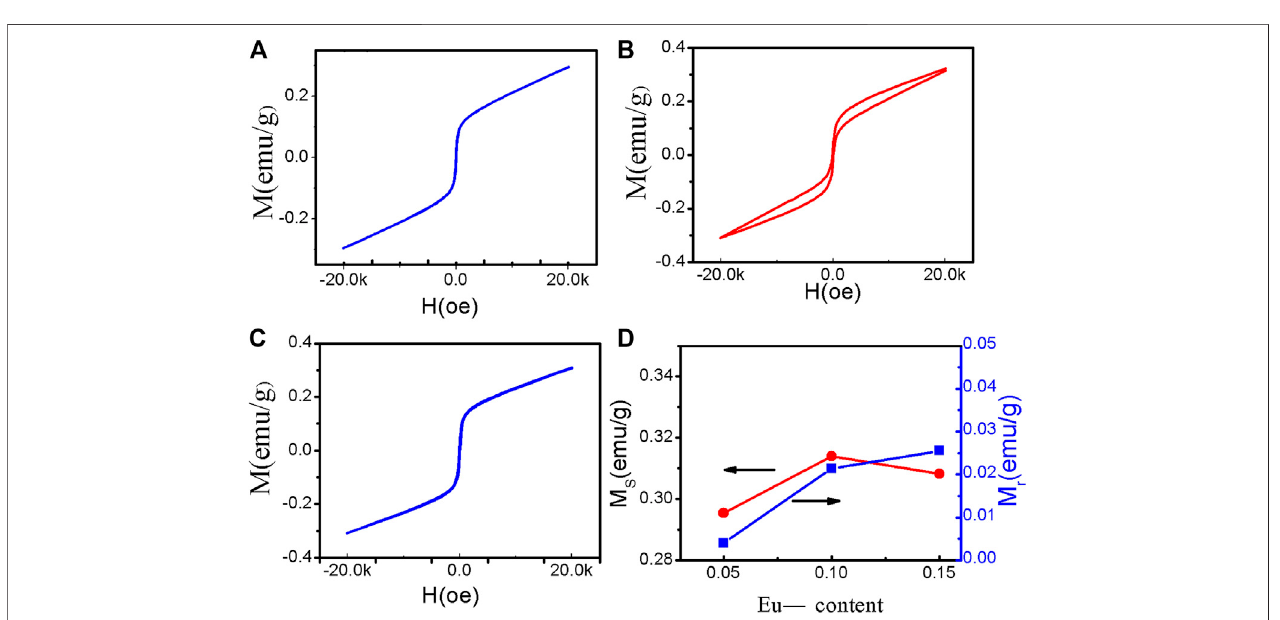
FIGURE 7 | Magnetic hysteresis loops of the nanoparticles at RT: (A) BSFO – 5Eu, (B) BSFO – 10Eu, and (C) BSFO – 15Eu. (D) Eu-substituted concentration dependencies of M r and M s